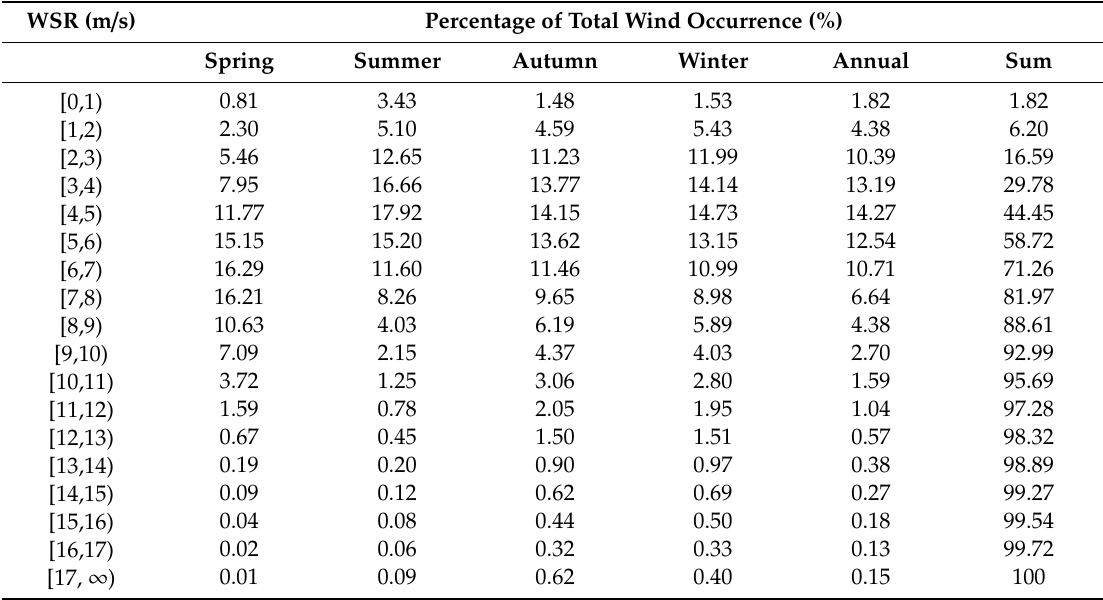
Table 2. Percentages of the annual and seasonal wind speed ranges (WSRs).